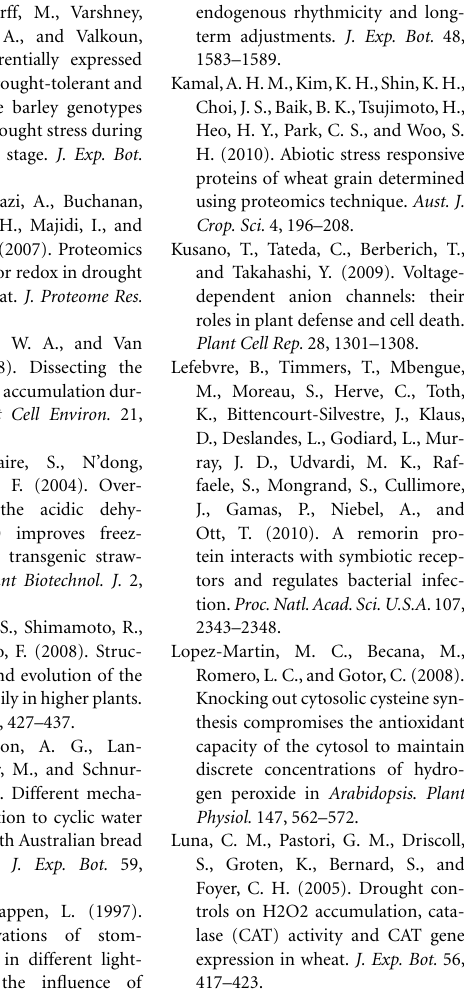
Table S1 | Complete list of proteins and corresponding peptides within functional categories. Table S2 | iTRAQ results, fold change and SE of cyclic drought-treated samples compared to well-watered controls. Significant changes indicated in bold, increases in red, and decreases in